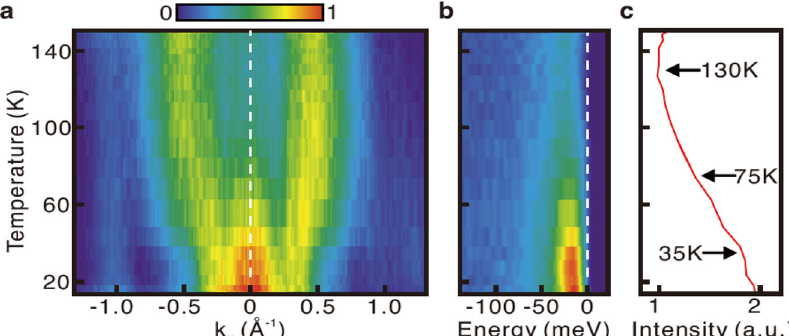
Fig.5|Heavyfermioncoherence.a Temperaturedependenceofspectralintensity ina30meVwindowattheFermilevelisshownalongthe X (cid:2) Γ (cid:2) X momentumaxis using h ν =112eVphotons. b TemperaturedependenceofARPESdataatthe Γ -point